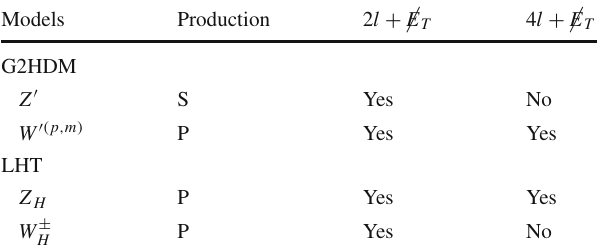
Table 6 Classification and search strategies of the gauge bosons in G2HDM and LHT by single (S)/pair (P) productions and two decay channels Models